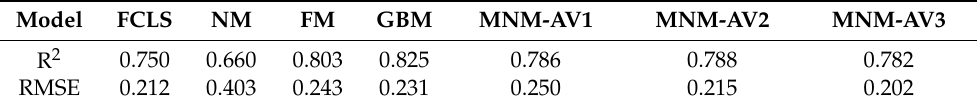
Table 3. Assessment of mosses abundance estimates derived with different models.